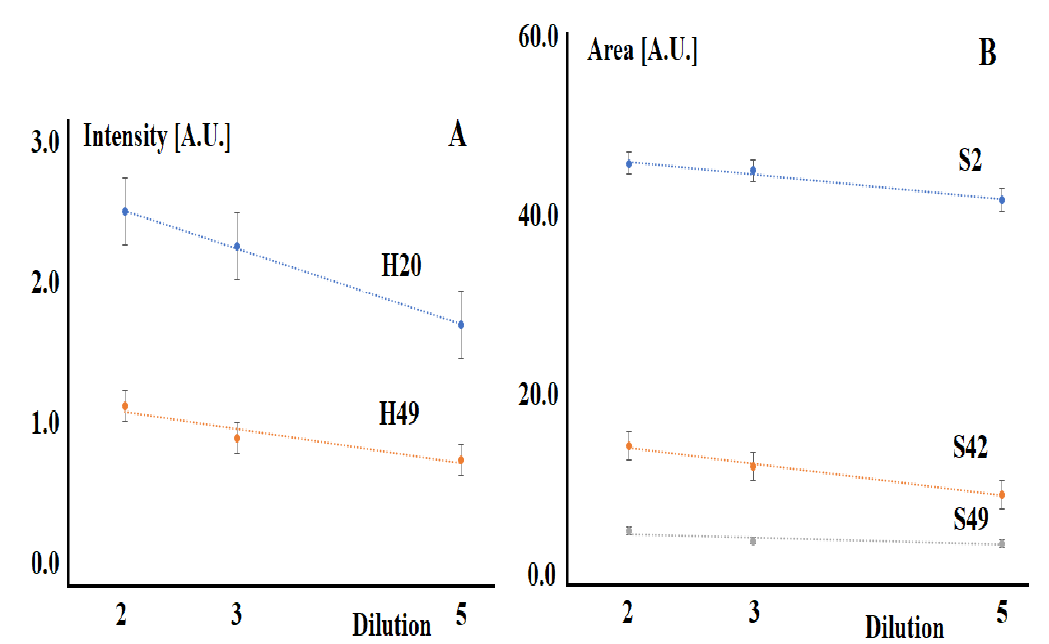
Figure 3. Changes in the absorbance ( A ) and areas ( B ) of characteristic absorption bands upon dilution of model solutions. The correlation coefficients between the intensities and areas of absorption bands and dilution are equal for H20 — 0.9992, H49 — 0.9165, S2 — 0.9762, S42 — 0.9887, S49 — 0.7719, p < 0.05.